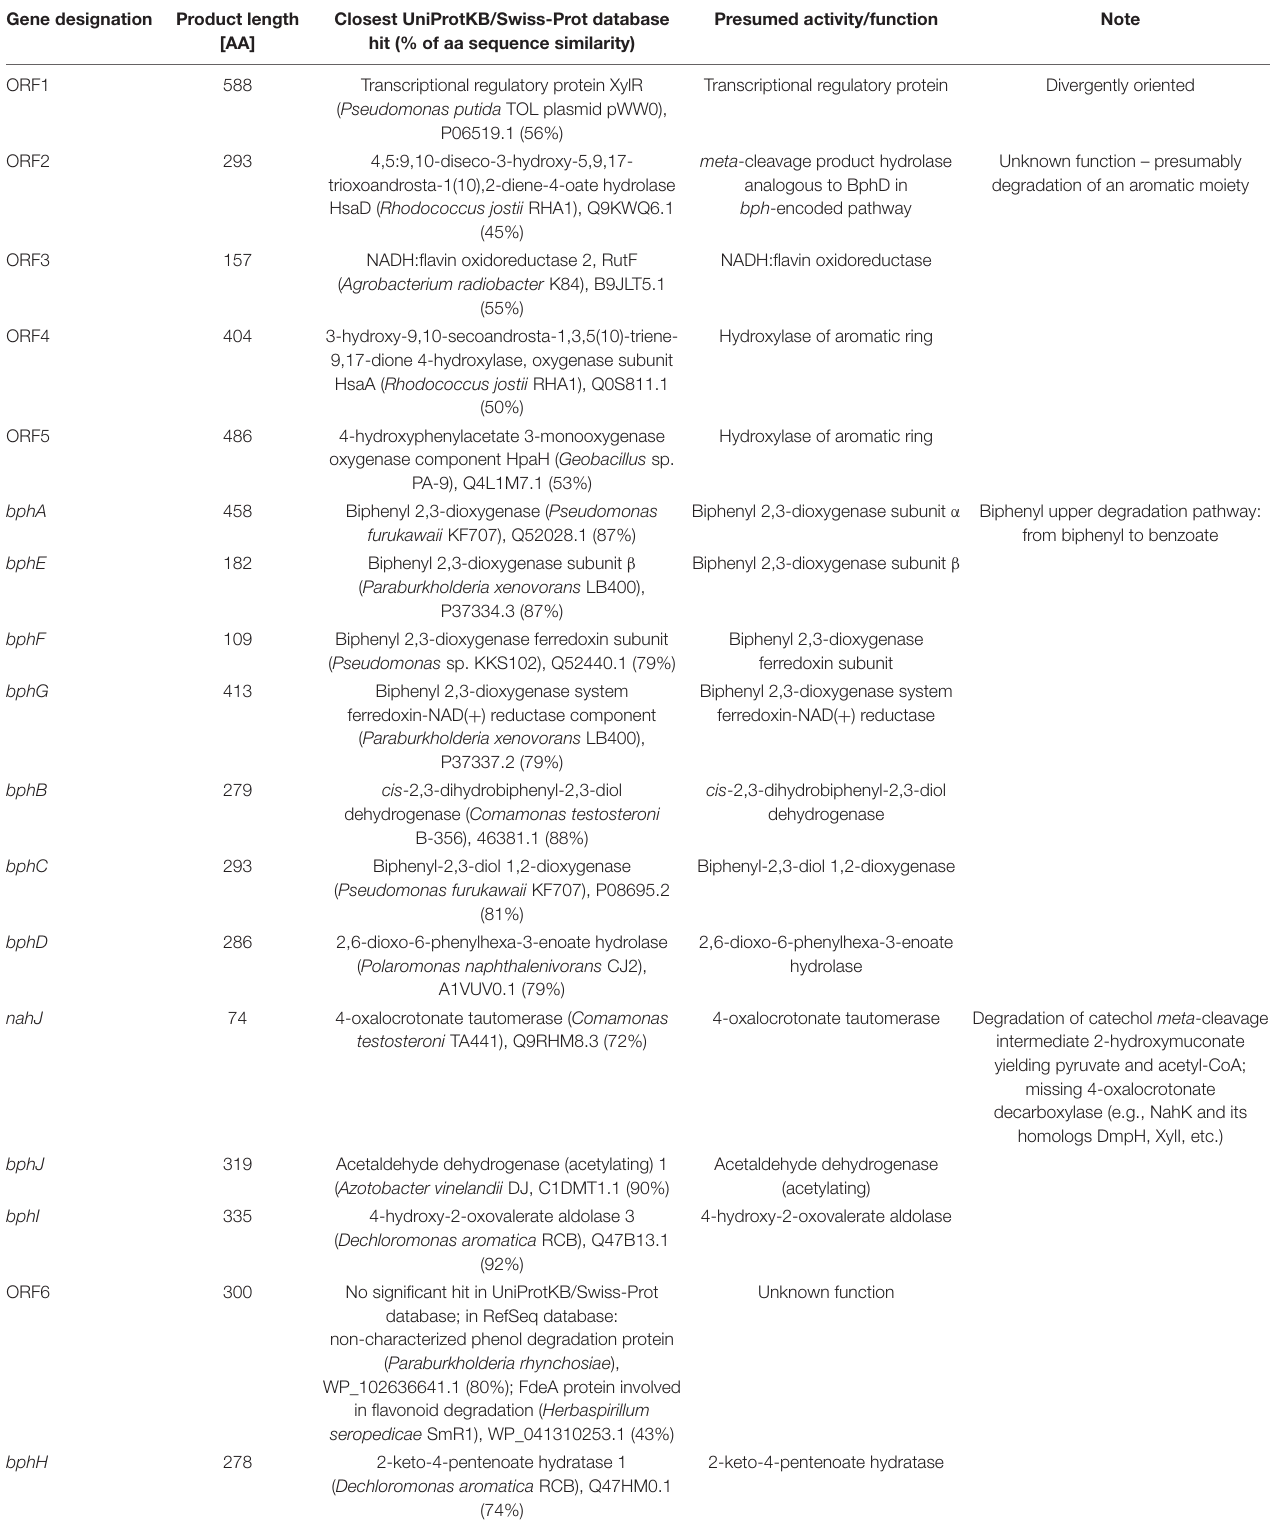
TABLE 1 | Functional assignment of deduced proteins encoded by ORFs within the AVS